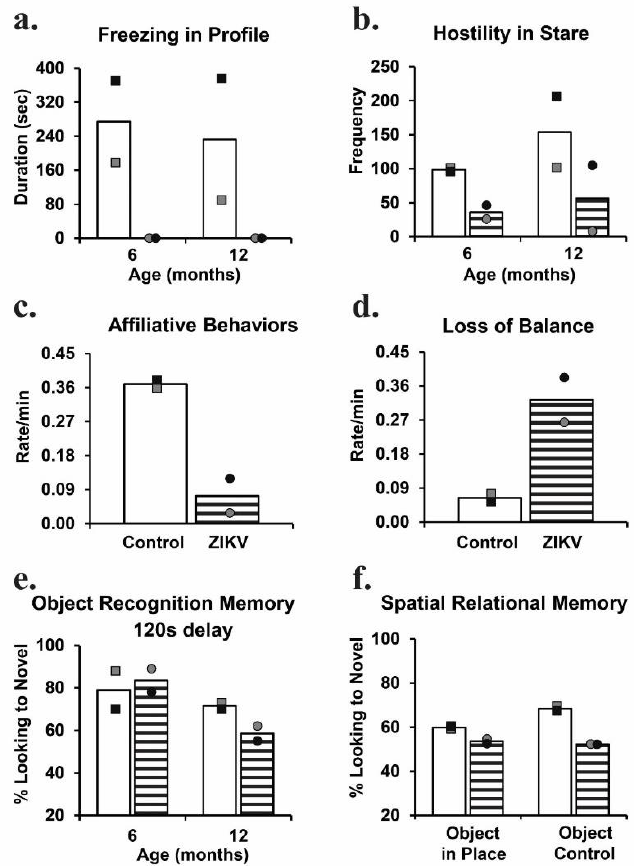
Figure 1. Behavioral consequences of postnatal ZIKV infection. This illustrates the changes in the emotional reactivity ( a , b ), social behavior ( c ), motor functions ( d ), and cognition ( e , f ) of the ZIKV-infected infant macques (dashed bars with circles) and controls (open bars with squares). Reproduced with modifications from Mavigner, et al. (2018) [72] and Raper et al. (2020) [73].